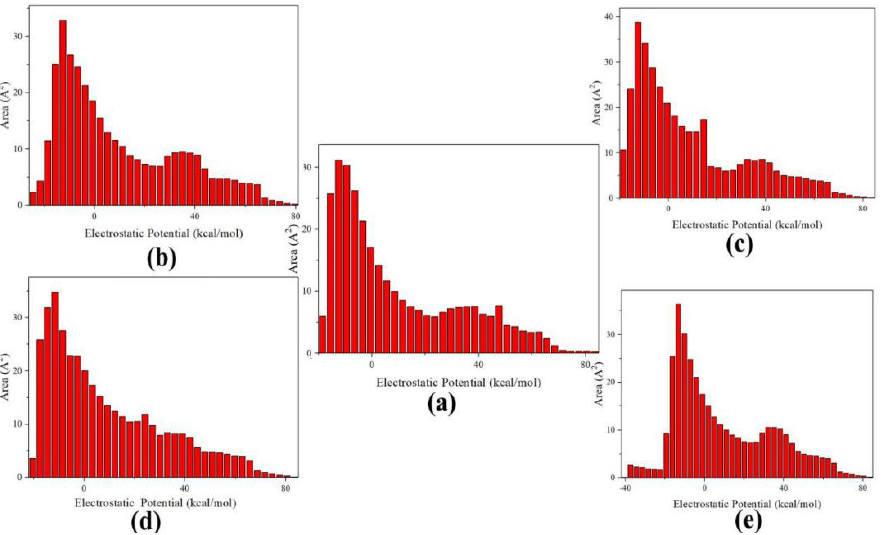
Figure 8. Surface area in each ESP range on the vdW surface of: ( a ) CL － 20, ( b ) CL － 20/H 2 O 2 , ( c ) CL － 20/CO 2 , ( d ) CL － 20/N 2 O, and ( e ) CL － 20/H 2 O. It can be seen that oxygen atoms of NO 2 have negative surface potential, while C-H and cage have positive surface potential as demonstrated in Figure 7. The O of CO 2 is closer to CL-20 and possesses negative ESP ( − 13.7 kcal·mol − 1 ). The ESP of the CL-20 frag- ment, which is close to CO 2 , is also negative ( − 19.54, − 18.87 kcal·mol − 1 ). This determines that the two molecules are mutually exclusive. Of the two negative ESP for O atoms of N 2 O, one ( − 16.18 kcal·mol − 1 ) is inter-attraction with positive ESP (44.63, 43.74 kcal·mol − 1 ) of CL-20. The other ( − 19.38 kcal·mol − 1 ) is mutually repulsive with negative ESP ( − 18.08, − 19.42 kcal·mol − 1 ) of CL-20. The equilibrium of the two forces determines the distribution of the CL-20 fragments and N 2 O. The two hydrogen atoms possess positive ESP (46.83 and 47.31 kcal·mol − 1 ), corresponding with the negative ESP ( − 14.46 and − 19.68 kcal·mol − 1 ) of the CL-20 fragment. The H…CL-20 contacts are of mutual affinity. Between the two negative ESP, there are many higher positive ESP relatively far from H 2 O. The H 2 O…CL- 20 contacts are mutually repulsive. The balance of the two forces determines the distribu- tion of the CL-20 fragments and H 2 O. In the configuration of CL-20/H 2 O 2 , the negative surface potential of CL-20 ( − 25.40 kcal·mol − 1 ) overlaps with the positive surface potential of H in H 2 O 2 (43.8 and 46.02 kcal·mol − 1 ), indicating that noncovalent CL-20…H 2 O 2 bonds are formed at the same time. The interaction between CL-20 and H 2 O 2 is bigger than other host and guest molecules. The values of the electrostatic interaction energy between CL- 20 and the guest molecules are shown in Table 1. Figure 8 illustrates the characteristic of ESP distribution of CL-20 and the additional guest parts in the CL-20 unit cell, respectively. For ESP distribution of CL-20, the positive part mainly arises from the positively charged C-H carbon atoms. The remarkable positive and negative ESP value are small areas, corresponding to the regions closed to the global ESP minimum ( − 18.5 kcal·mol − 1 ) and maximum (83.5 kcal·mol − 1 ), respectively. The whole CL-20 surface partition is affected by the different guest molecules. For the CL-20, the vdW surface area is 310.16 Å 2 . By comparing the experimental data, the proportion of ESP distribution of the CL-20 fragment occupies, in order: 81.4%, 84.1%, 86.6%, and 90.7% of the overall surface for CL-20/N 2 O, CL-20/CO 2 , CL-20/H 2 O, and CL-20/H 2 O 2 , respectively. It shows that the H 2 O 2 guest has the least effect on the surface area of host–guest cell. CL-